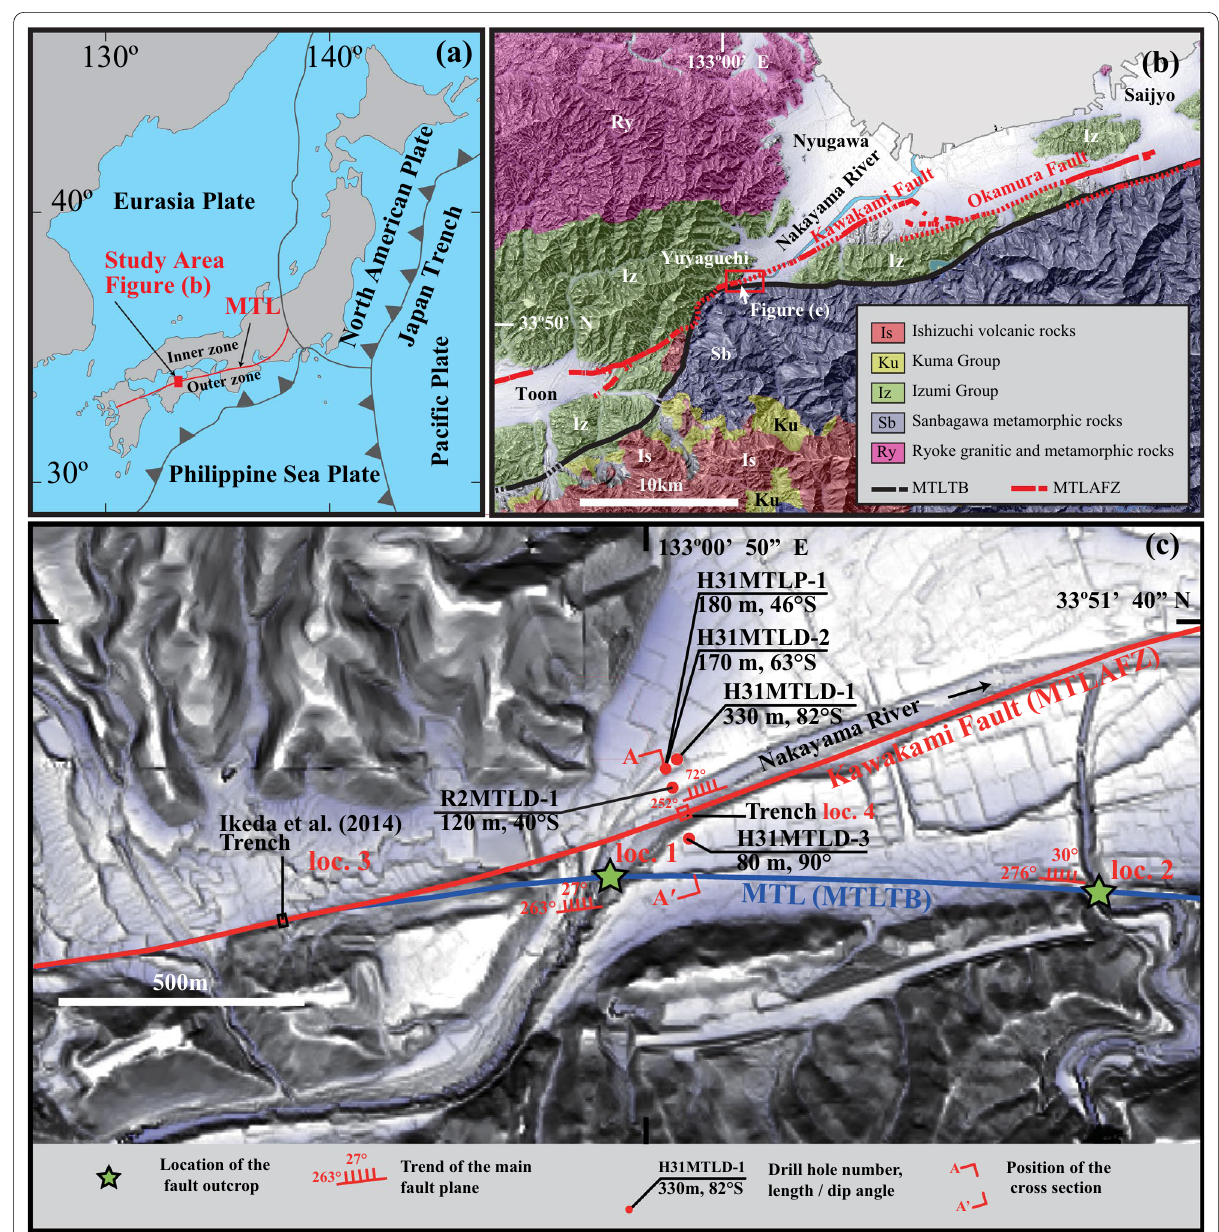
Fig. 1 Geological setting of the MTL and locations of the investigation sites. a The tectonic setting of the Japanese Islands; b geological map of the northwestern Shikoku Island; c locations of drilling and trench sites. The geological map was modified from a seamless digital geological map of Japan (1:200 000) edited by the Geological Survey of Japan (2017). Active fault data were compiled from Nakata et al. (1998), Goto et al. (1998), and Tsutsumi et al. (1998). The shaded relief map was created using a 5-m DEM obtained from the Geospatial Information Authority of